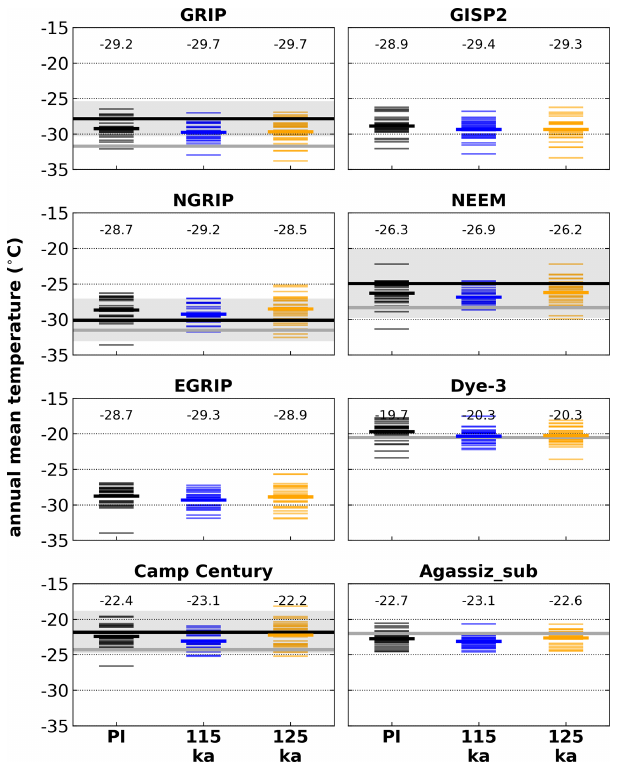
Figure 3. Mean (near-surface) JJA (June–July–August) tempera- ture at Greenland ice core locations simulated by the MAR climate model for three time slices. Individual model years (short thin lines) and the mean (short bold lines, numerical value on top of columns) are compared to mean observations from weather stations (long bold lines in